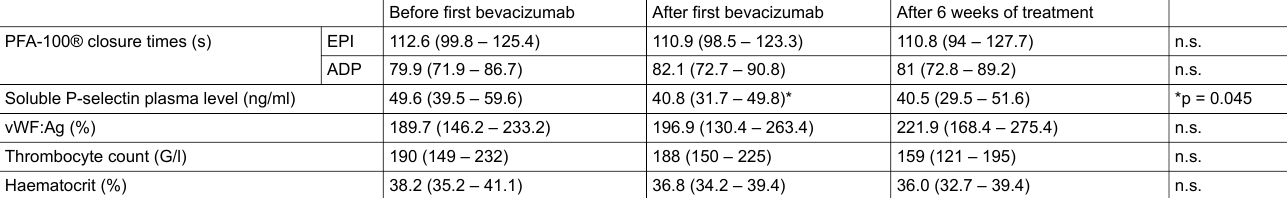
Table 3: Results from the clinical observation study, PFA-100® closure times, soluble P-selectin serum levels and haematological parameters (mean value with 95% confidence interval); n.s. = not